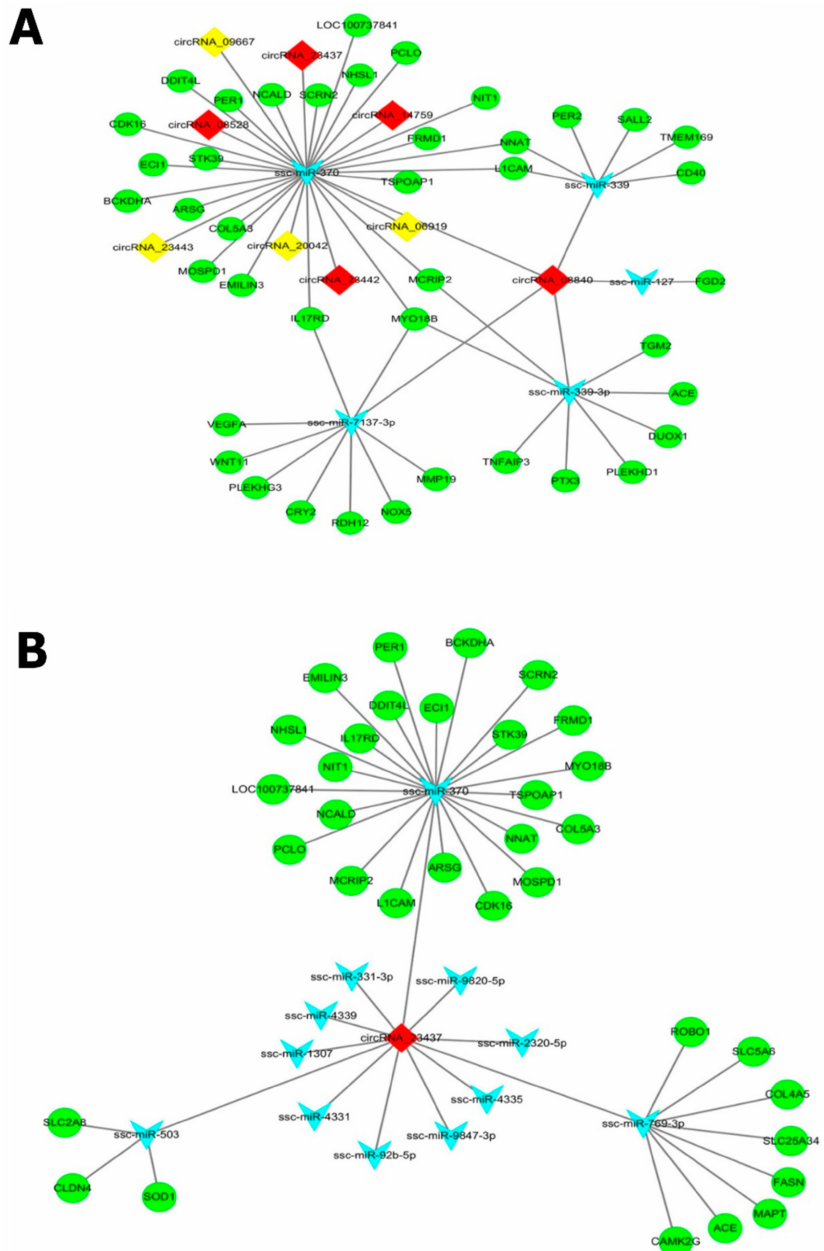
Figure 4. After the identification of two lipid metabolism-associated circRNAs, a ceRNA network was constructed from these two circRNAs through a regulatory network of circRNAs, miRNAs, and mRNAs. ( A ) circRNA_08840 binds to 5 miRNAs and their target genes. ( B ) circRNA_23437 binds to 12 miRNAs and their target genes. Note: the red color represents upregulated circRNAs, yellow represents downregulated circRNAs, blue denotes miRNAs, and the green represents